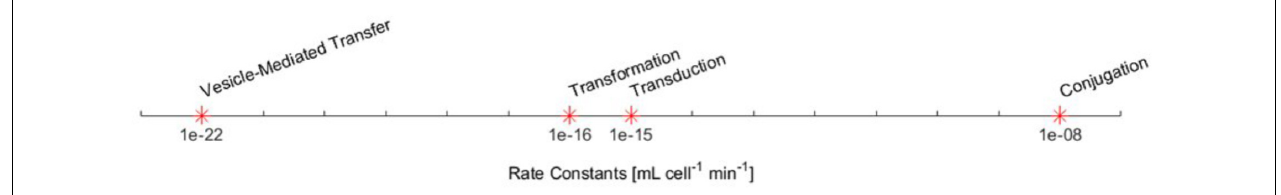
FIGURE 2 | The derived maximum rate constants for the four HGT